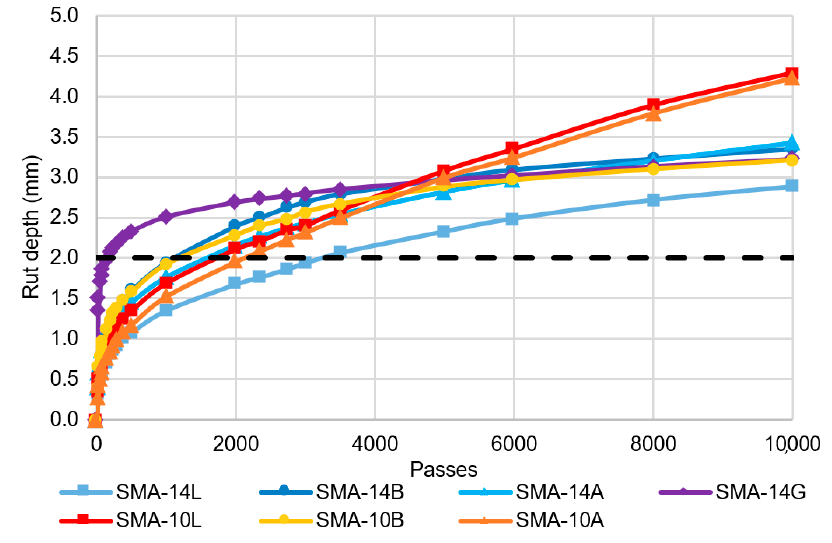
Figure 8. Wheel track depth growth.